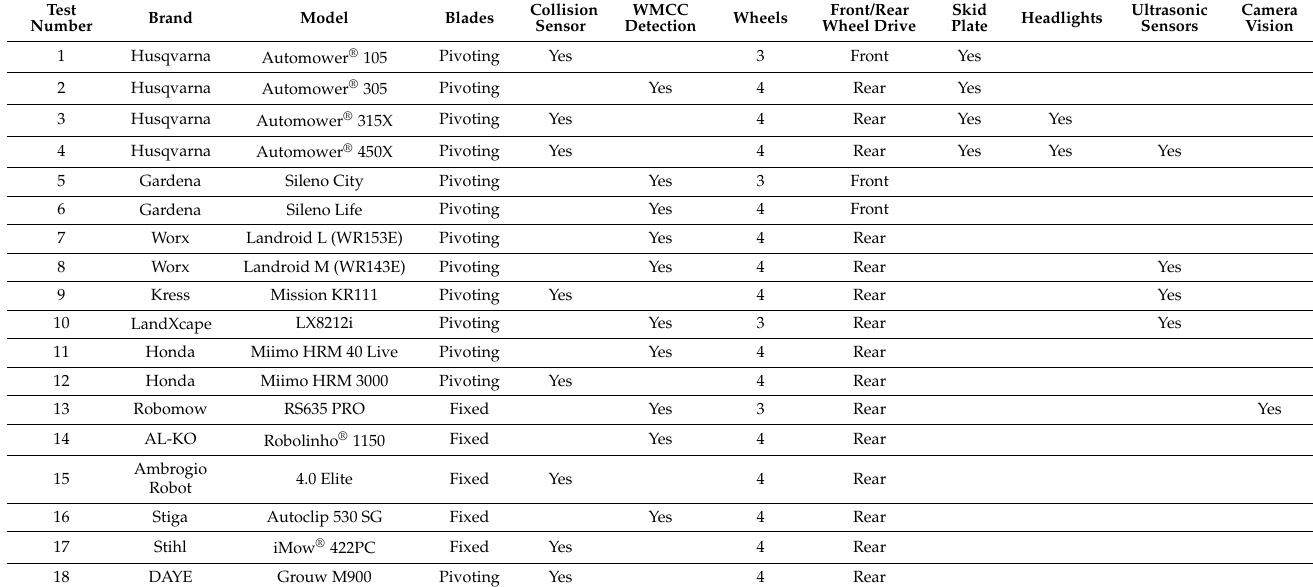
Table 1. Overview of the models of robotic lawn mowers tested. In the column “Blades”, Pivoting indicates “low energy pivoting blades” and Fixed indicates “heavy duty fixed blades”. WMCC detection is short for “wheel motor current collision detection”.